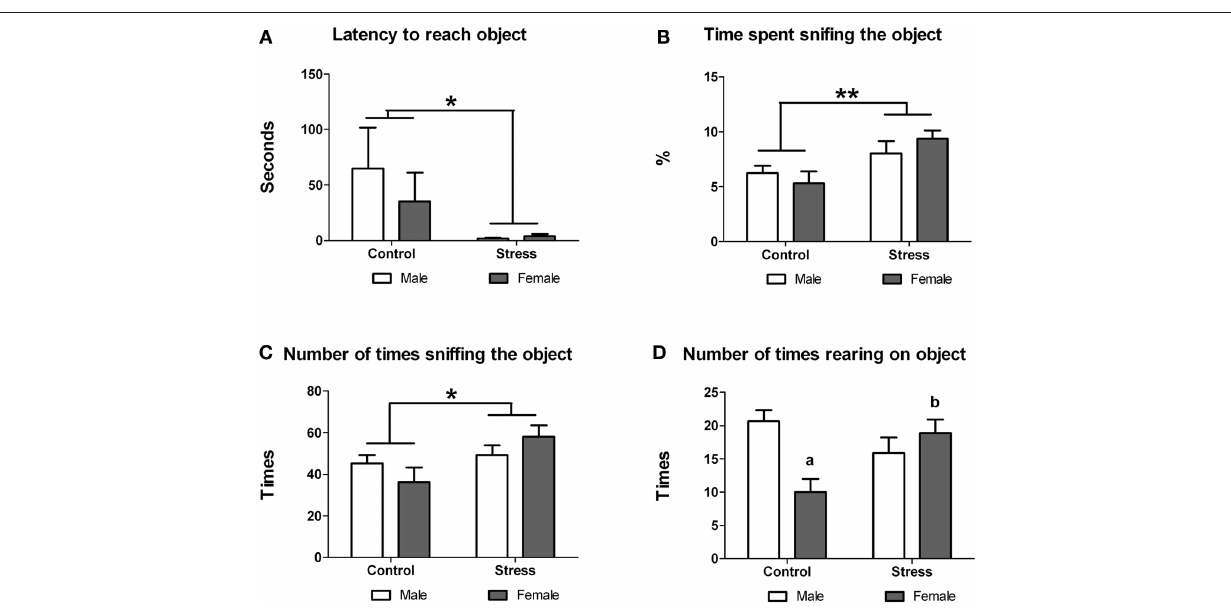
Figure 6B ]. No sex differences or treatment × sex interaction were observed in both tests. PlasMa glucose and cortIcosterone levels